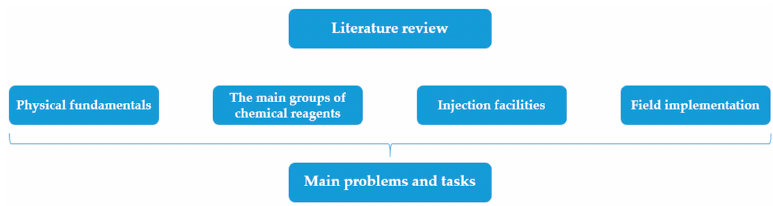
Figure 1. Enlarged research methodology [designed by authors].